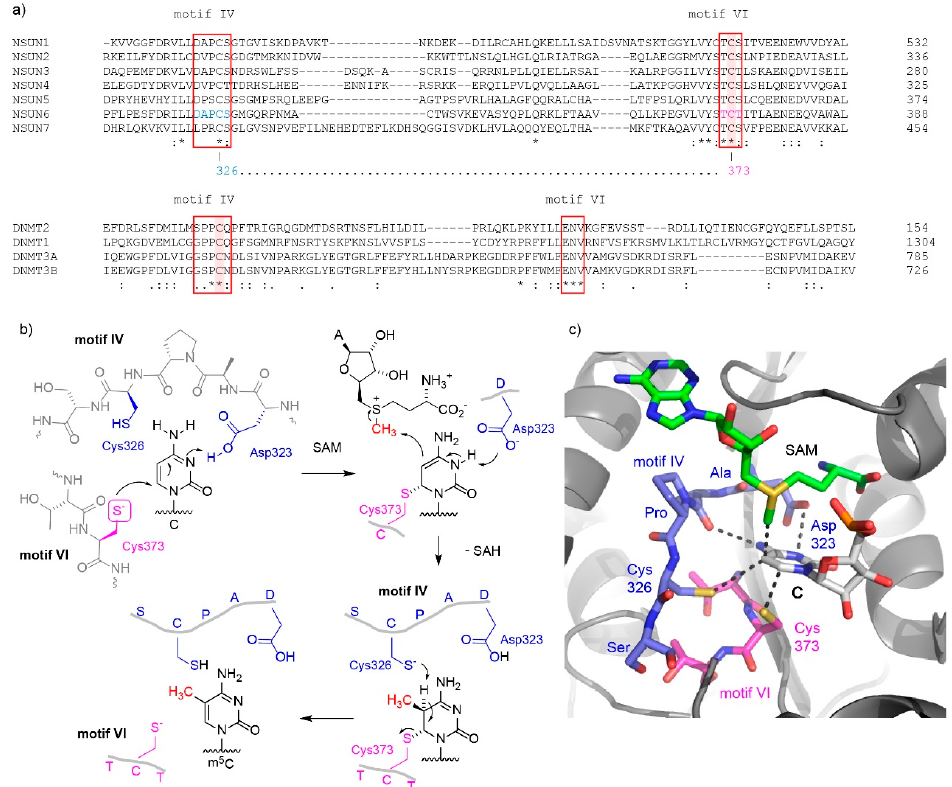
Figure 1. Mechanisms of C5-methylation of cytosine by m 5 C RNA methyltransferases. ( a ) Amino acid